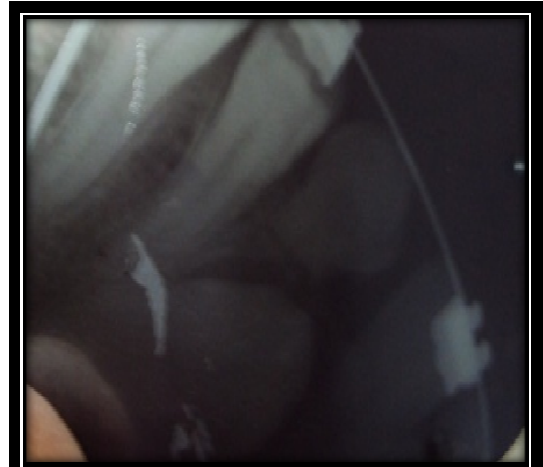
Figure 8: Periapical eriapical surgery for maxillary surgery for maxillary left central incisor with left central incisor with periapical